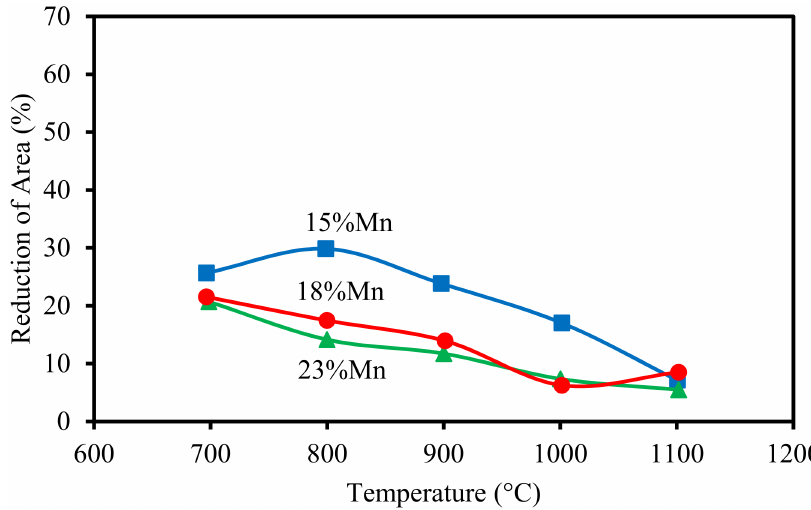
Figure 15. Influence of Mn content on the ductility of high Al containing TWIP steels. The base composition of the steels was 0.6% C, 0.007% P, 0.008% S and 1.5% Al [32].